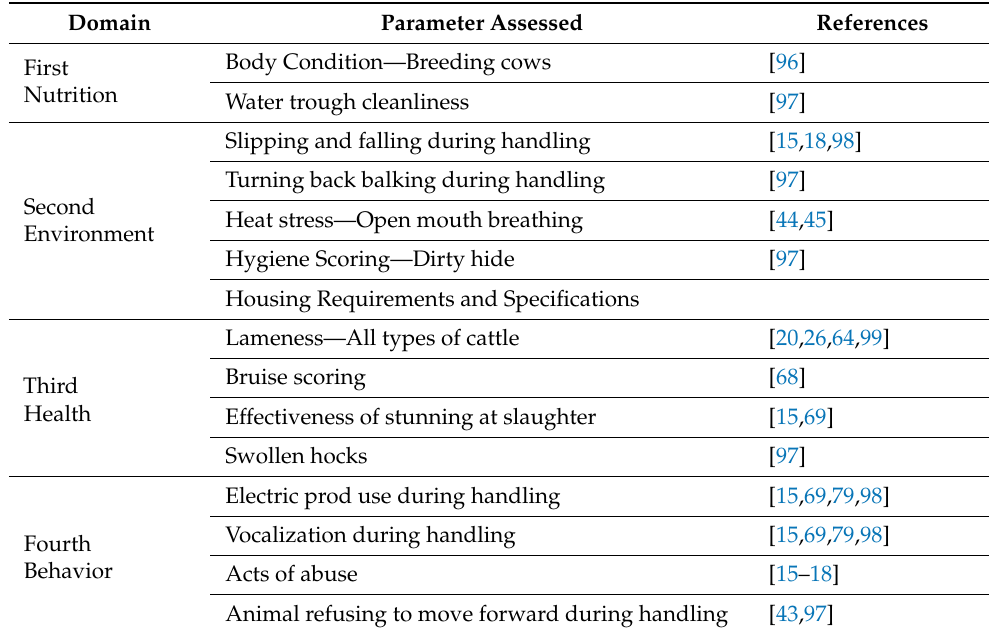
Table 1. Guide to Assessment Tools for Key Welfare Indicators for Beef Cattle.